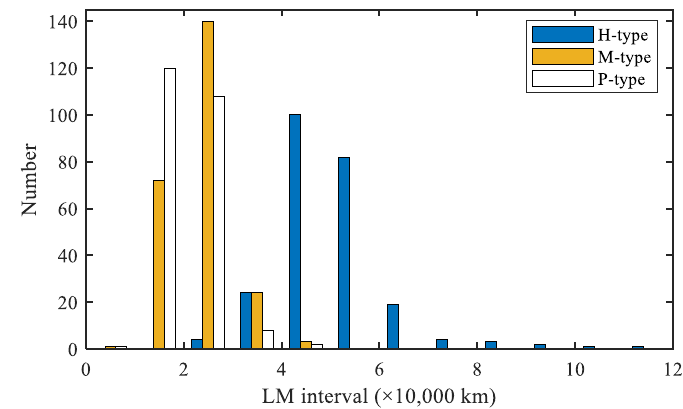
Figure 3. The LM histogram of the three types of PCCS.